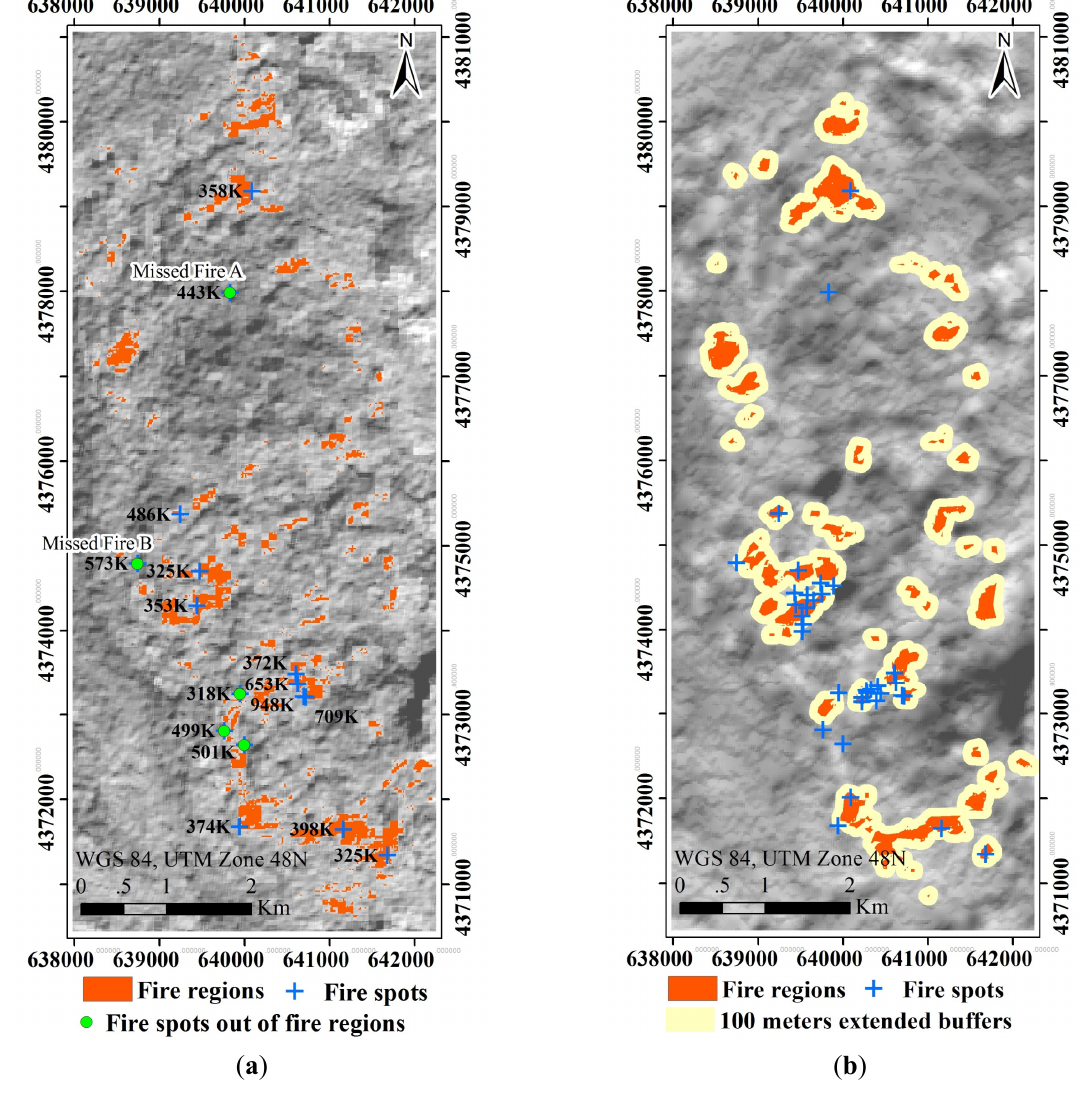
Figure 10. Spatial distribution of measured fire spots (blue crosses and green circles) and coal fire areas (orange) from our self-adaptive gradient-based thresholding (SAGBT) method. Blue crosses are matches between fire spots and fire areas. Green circles indicate fire spots in the proximity of fire areas. Temperatures (K) are presented for each spot. ( a ) Coal fires extracted from ASTER TIR image acquired on 27 March 2013; ( b ) Coal fires extracted from Landsat 8 TIRS acquired on 23 December